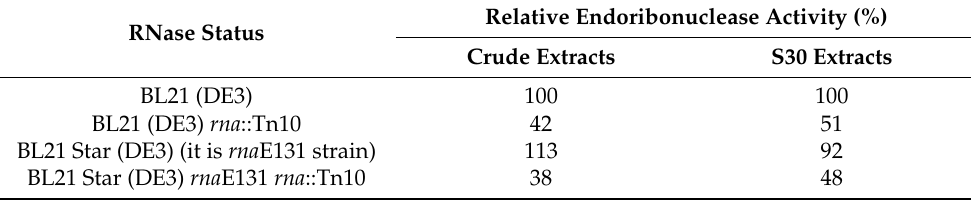
Table 1. Endoribonuclease activity in engineered E. coli strains.